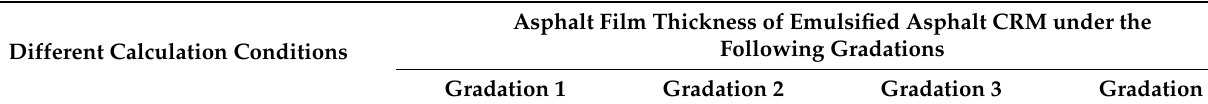
Table 6. New asphalt film thickness of CRM under different gradations and emulsified as- phalt